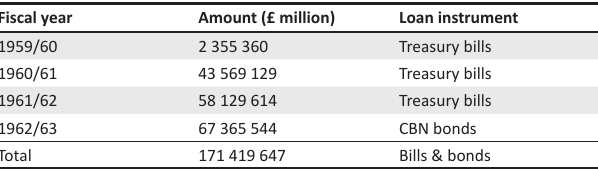
TABLE 2: Domestic loans received by the Nigerian government, 1959/